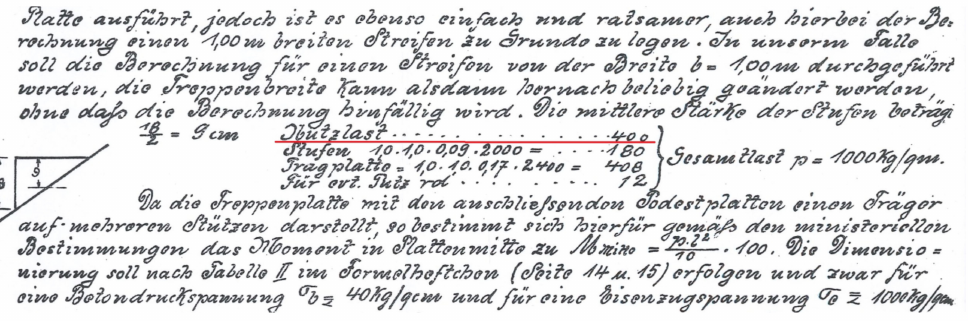
Figure 14. The fragment of calculations from publication [33]. Translation